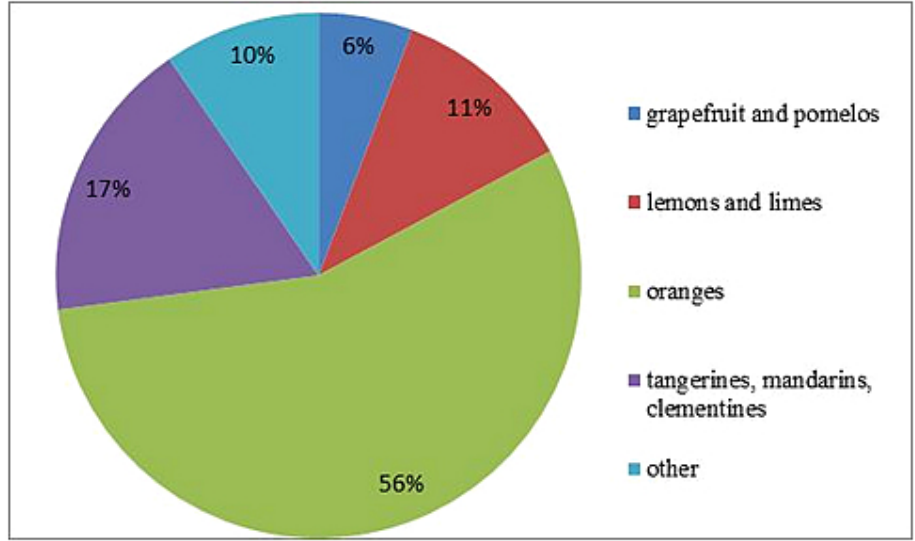
Figure 1. World production of citrus by fruit type in 2010 [7].